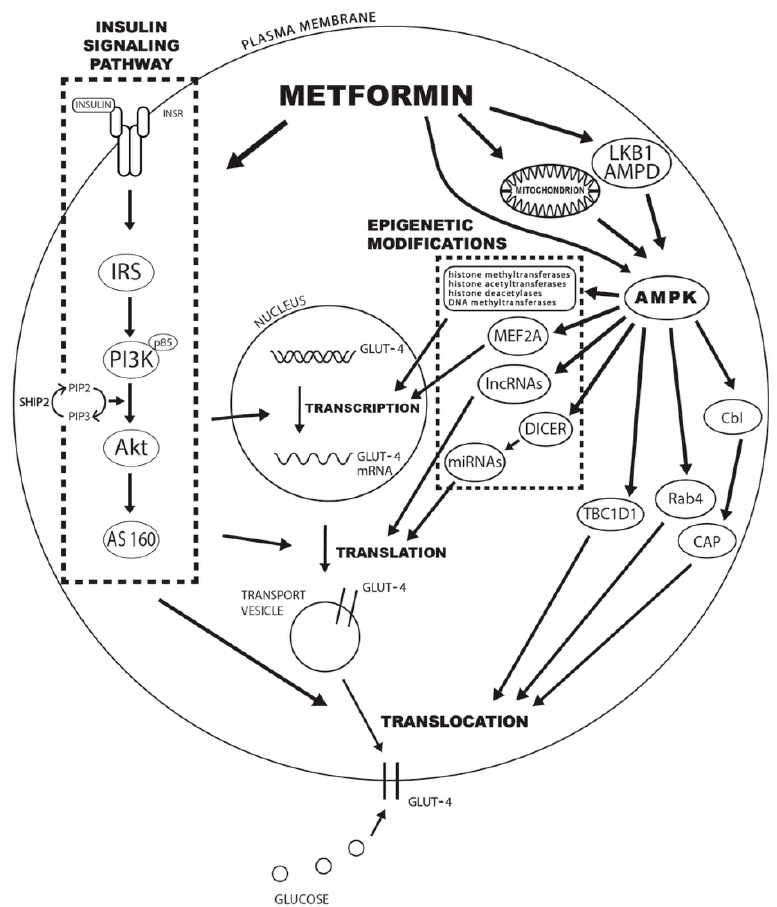
Figure 1. The potential mechanisms of metformin’s effect on increased GLUT4-mediated glucose transport include changes in insulin signaling pathway mediators, AMPK activation, epigenetic modifications, and enhancements in GLUT4 trafficking and translocation to the plasma membrane.